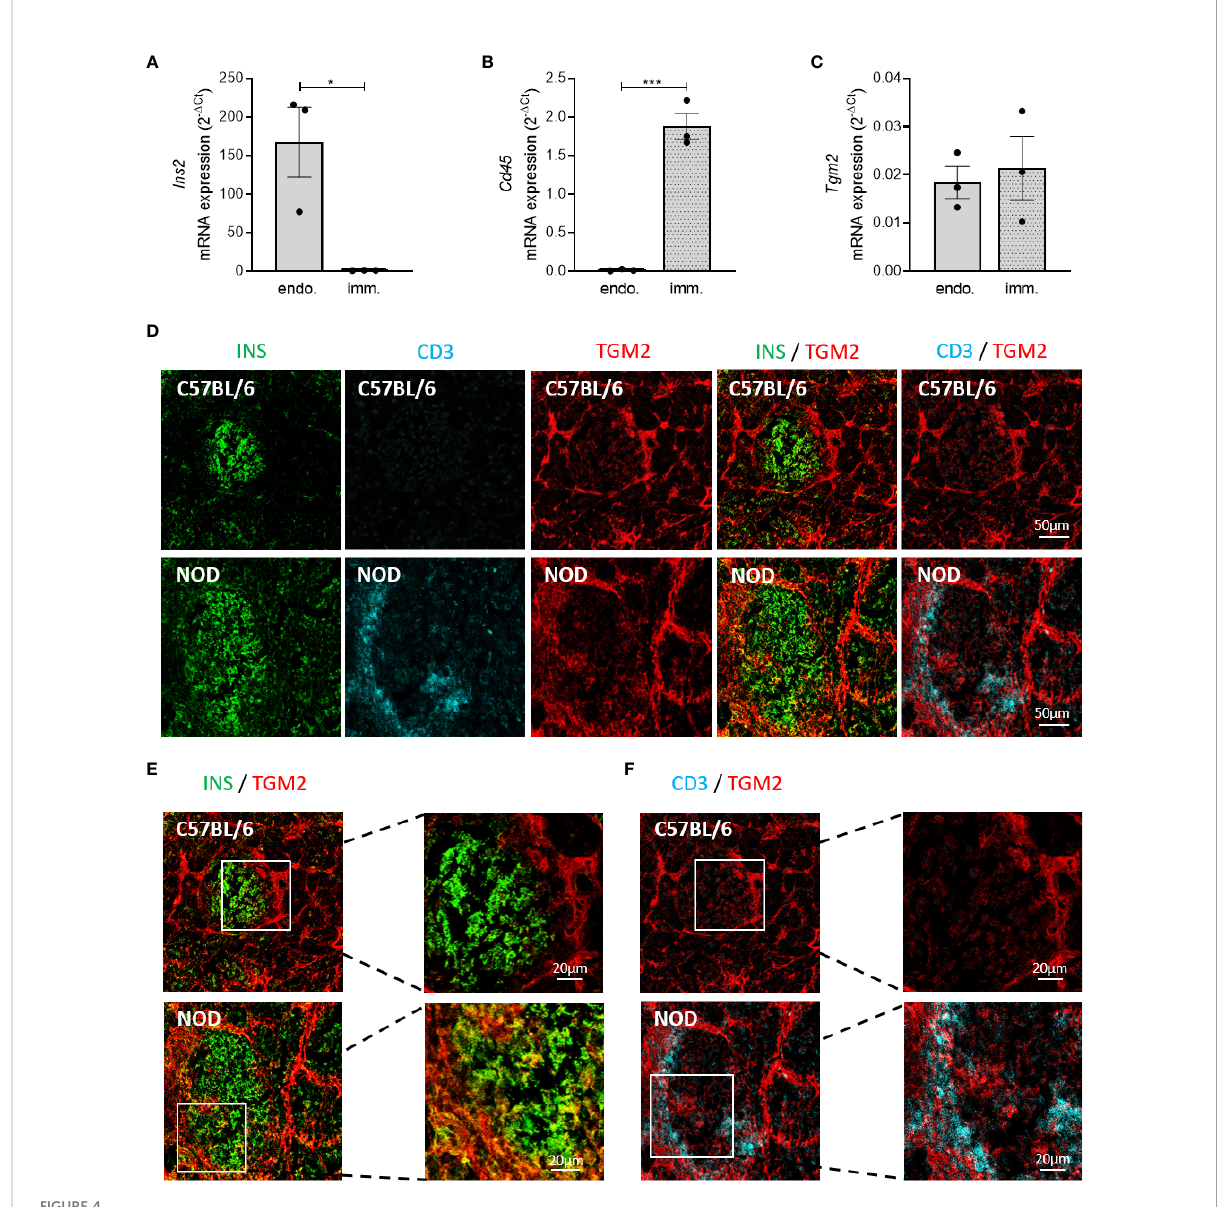
FIGURE 4 Increased Tgm2 levels in islets of Langerhans of NOD mice are induced by cytokines. Tgm2 is expressed by both b -cells and in fi ltrating immune cells. Tgm2 RNA levels in control C57BL/6 islets and C57BL/6 islets exposed to IL1 b and IFN g for 24 hours. Tgm2 Ins2 (A) , Cd45 (B) and Tgm2 Ins2 (C) mRNA levels in CD45 + (immune) and CD45 - (endocrine) sorted fractions of NOD islets. (D) TGM2 protein expression in murine islets of Langerhans. Confocal microscopy of frozen pancreas tissue section from 10-week-old C57BL/6 and NOD mice. Immune cells are visualized by CD3 staining, b -cells by insulin. (E) Zoom in of INS and TGM2 merged image in C57BL/6 and NOD islets. (F) Zoom in of CD3 and TGM2 merged image in C57BL/6 and NOD islets. Data are shown as mean with SEM. Unpaired t-test, *p < 0.05, ***p <